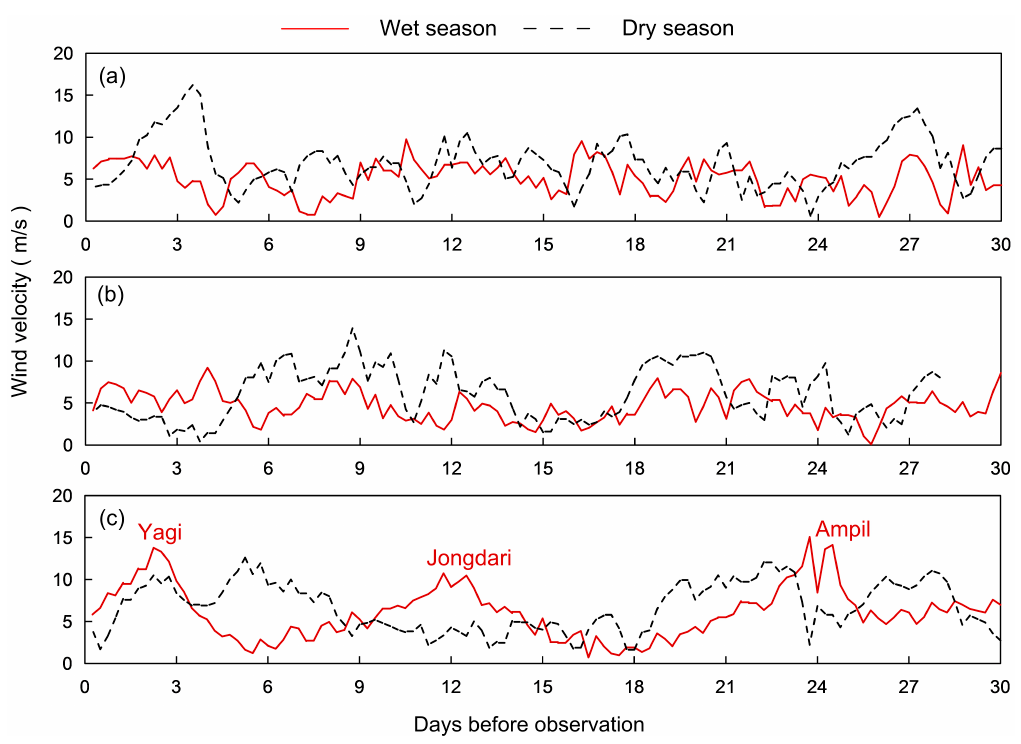
Figure 9. Wind speeds near NPJ station before observations: ( a – c ) represent 2016, 2017 and 2018, respectively.